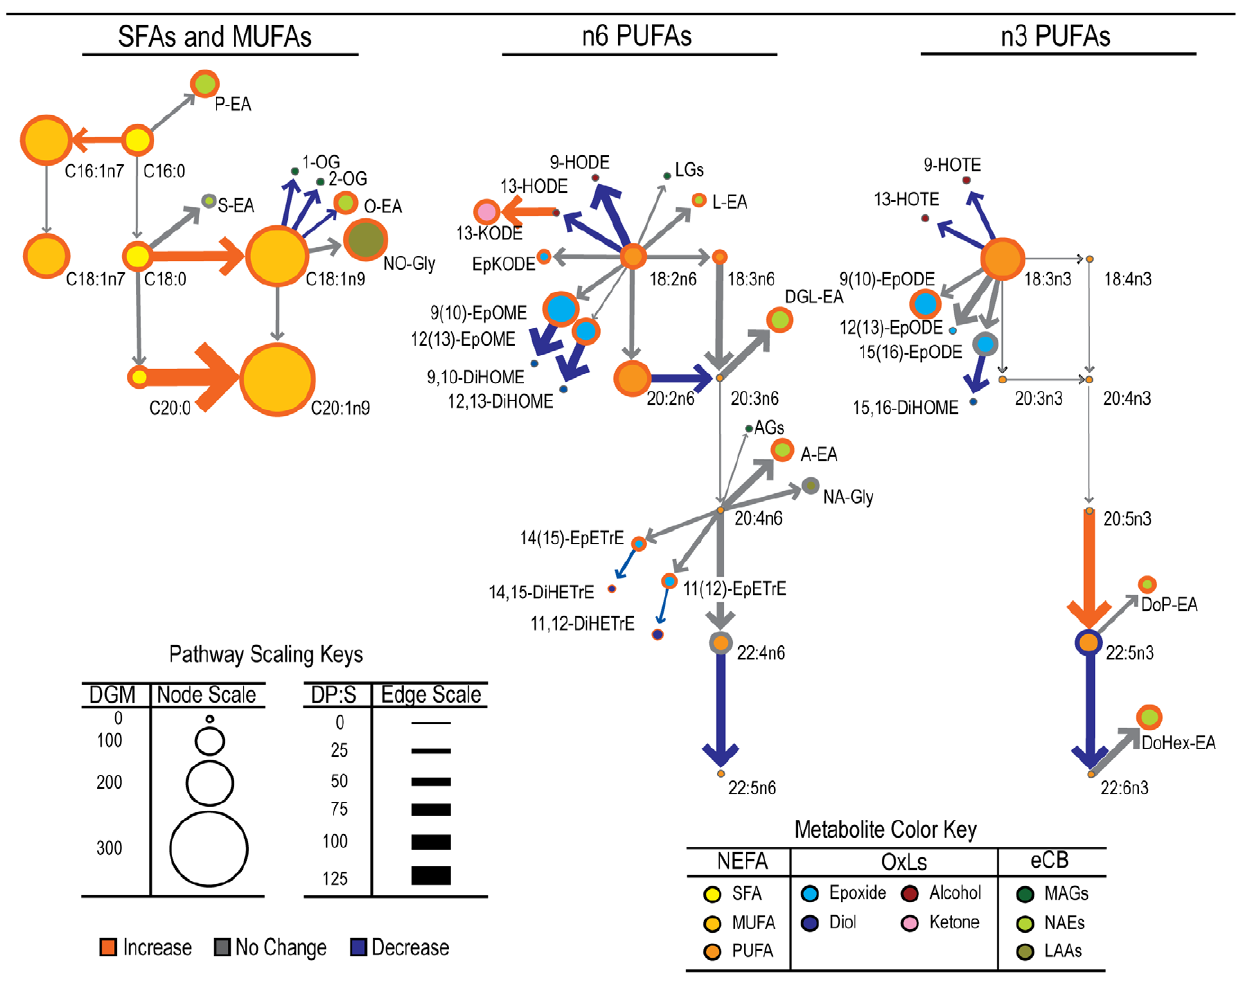
Figure 1. The type 2 diabetes-associated lipidomic changes projected in context of their biological relationships in obese African- American women. Metabolites are represented by circular ‘‘nodes’’ linked by ‘‘edges’’ with arrows designating the direction of the biosynthetic gradient (i.e. substrate to product). Some metabolites are linked by more than one enzymatic step. Node sizes represent magnitudes of differences in plasma metabolite geometric means ( D GM). Arrow widths represent magnitudes of changes in product over substrate ratios ( D P:S). Colors of node borders and arrows represent the significance and direction of changes relative to non-diabetics as per the figure legend. Differences are significant at p , 0.05 by Mann-Whitney U test adjusted for FDR